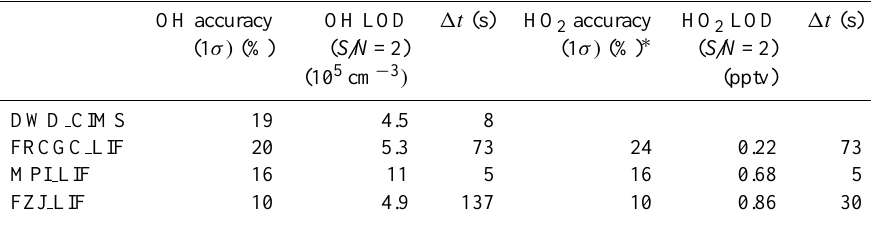
Table 1. Instruments measuring OH and HO 2 during the ambient measurement period of the HO x Comp campaign.